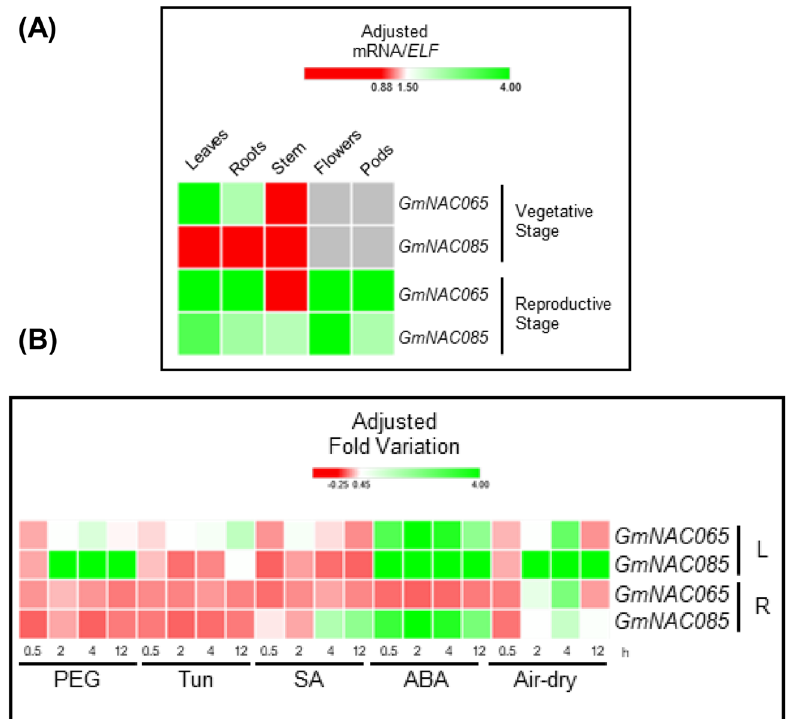
Figure 3. Tissue-specific expression of GmNAC065 and GmNAC085 in Williams 82 soybean seedlings under normal developmental conditions and different stresses. ( A ) Expression pattern of GmNAC065 and GmNAC085 in soybean vegetative and reproductive stages. Gene expression was determined by RT-qPCR (data available in Supplementary Figure 2A) and calculated using 2 −ΔCt method and ELF1A as the endogenous normalizer gene. ( B ) Expression pattern of GmNAC065 and GmNAC085 in soybean seedlings subjected to simulated drought (PEG 8000—10% w/v; air-dry and ABA—150 mM), ER stress (Tun—5 µg/mL), and biotic stress (SA—75 µM). The gene expression level was analyzed after 2 h, 4 h and 12 h treatments in leaves and roots by RT-qPCR (data available in Supplementary Figure 2B). Fold variation was calculated using the 2 −ΔΔCt method in three biological replicates and two technical replicates and normalized by Z-score considering gene expression in untreated